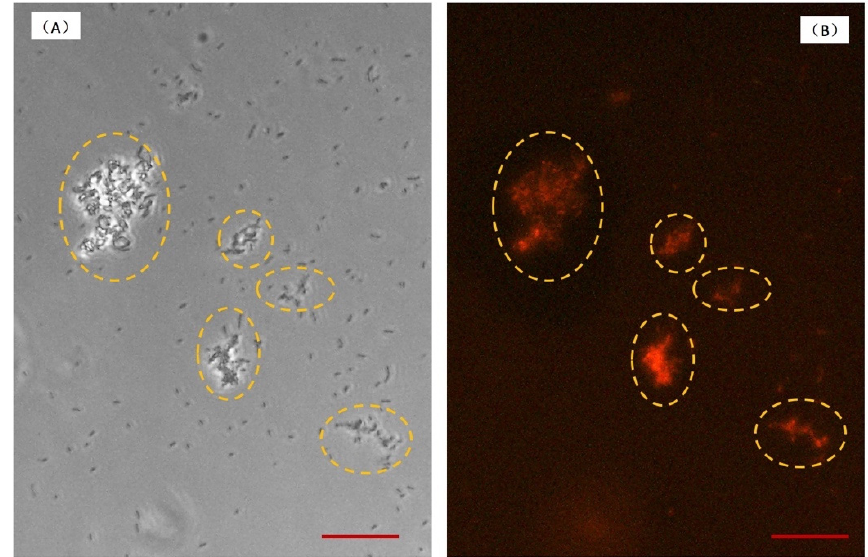
Figure 3. The image of biofilms in bright field ( A ) and in fluorescence ( B ). After 11 h culture, biofilms were stained by SYPRO Ruby in culture chamber. The scale bar is 20 μ m.